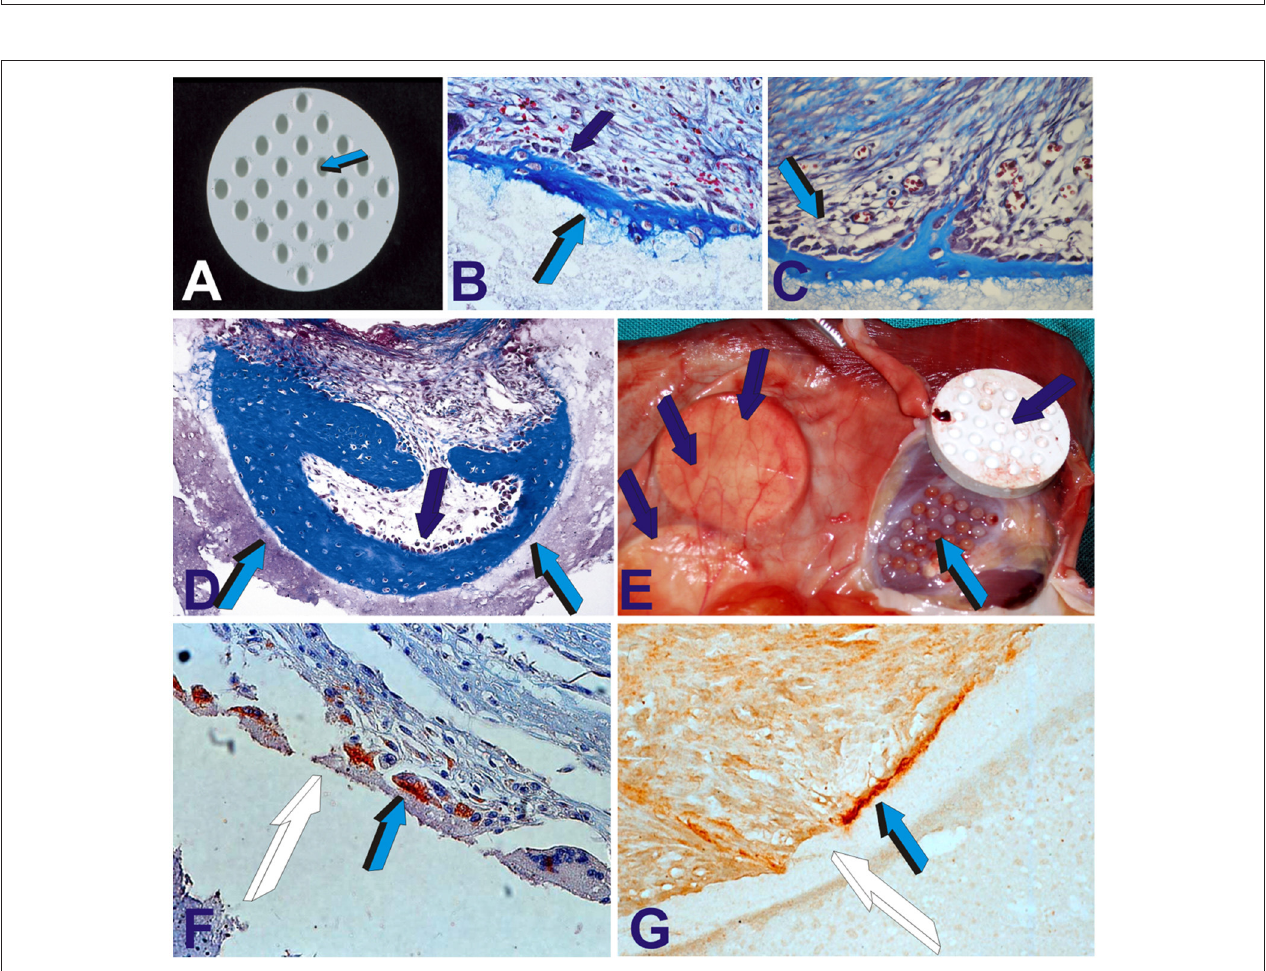
FIGURE 1 | condensations on day 30 (day 90 in C ) at the hydroxyapatite interface (light blue arrows) with capillary invasion (magenta arrows). Alkaline phosphatase staining and activity within both mesenchymal condensations (on day 60) (E) and capillary sprouting and invasion (on day 30) (F) . (G) Patterning and further morphogenesis of collagenous condensations at the hydroxyapatite interface with the development of osteoblast-like cells within the differentiating and remodeling condensations on day 30 (light blue arrows). (H,I) Further alkaline phosphatase staining (magenta arrows) of invading capillaries on day 30. Alkaline phosphate stains intensely within the multiple cellular layers of the sprouting branching capillaries in close contact with the hydroxyapatite substratum. (K) Macroporous construct harvested on day 60 shows laminin immunolocalization (light blue arrow) within invading capillaries penetrating the macroporous spaces. Type IV collagen and laminin’ amino acid motifs bind both angiogenic and bone morphogenetic proteins sequences which may be released during tissue induction and morphogenesis to initiate the induction of bone formation (Ripamonti, 2006, 2010 for reviews) Note the intimacy of laminin immunolocalization with large hyperchromatic endothelial cells, possibly preparing to migrate out of the vascular compartment. (J) On day 60, there is a continuous flow of responding mesenchymal cells (light blue arrows) moving from the vascular Trueta’s angiogenic vessels (magenta arrow) to the osteoblastic/osteogenetic differentiation site (dark blue arrow). The digital image in (J) depicts the critical differentiating role of the nanopatterned geometric substratum on the induction of cellular differentiation, osteoblast synthesis and the induction of bone formation directly attached to the self-inducing nanopatterned calcium phosphate-based macroporous bioreactor (Ripamonti et al., 1993). (L) Bone morphogenesis later develops on day 90 within the macroporous spaces of the coral-derived bioreactors, with woven bone (light blue arrows in L ) with woven bone initiating within concavities of the substratum. (M,N) Bone induction and remodeling of the newly formed bone within concavities (light blue arrows) on day 90 after rectus abdominis implantation. Decalcified and undecalcified paraffin wax and Historesin sections cut at 3 to 6 µ m and stained with toluidine blue in 70% ethanol or (C) stained free-floating with modified Goldner’s trichrome stain (C) . Decalcified sections (M,N) also stained with modified Goldner’s trichrome stain.